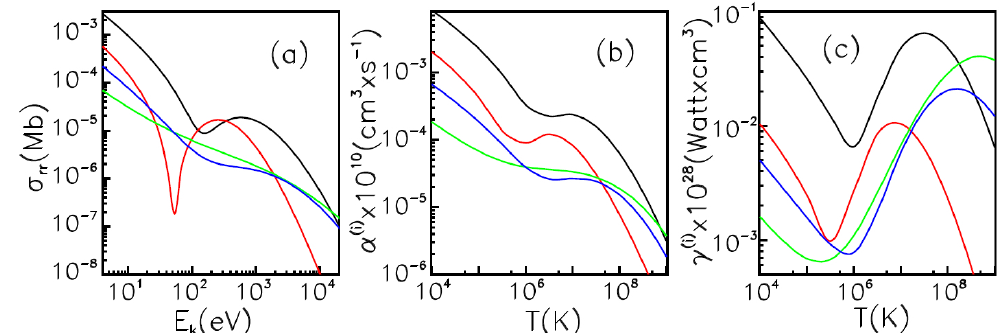
Figure 4. Partial RRCS ( a ), RR rates ( b ) and RPL rates ( c ) for the recombination of the W 6+ ion with an electron captured in various states. Black, the 5 d the 6 s ; blue, the 6 p 1 / 2 1 / 2